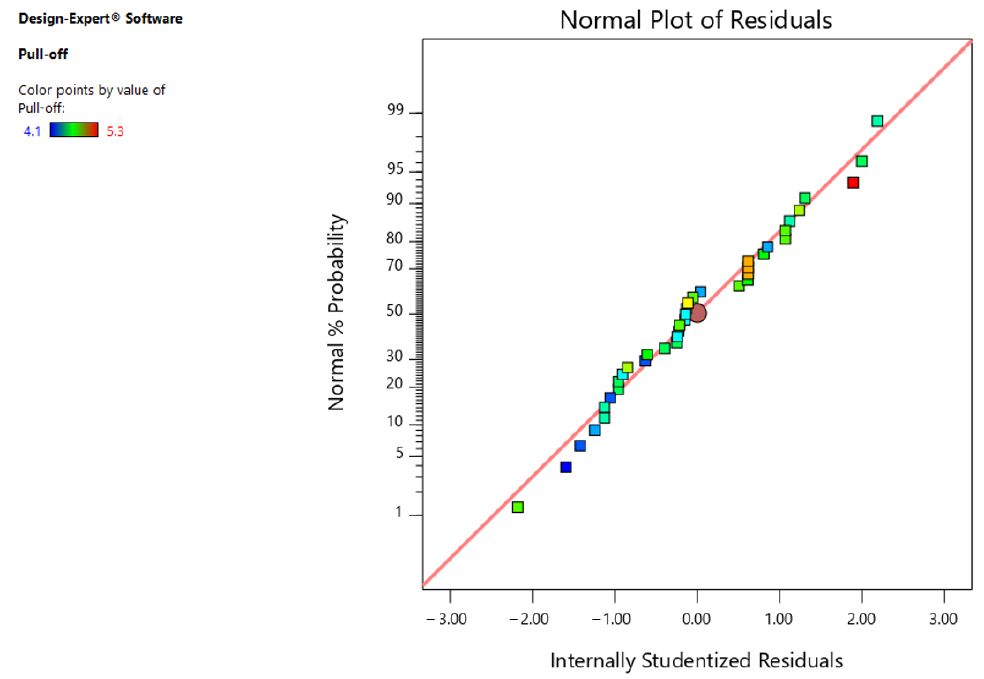
Coatings 2022 , 12 , x FOR PEER REVIEW 11 of 15